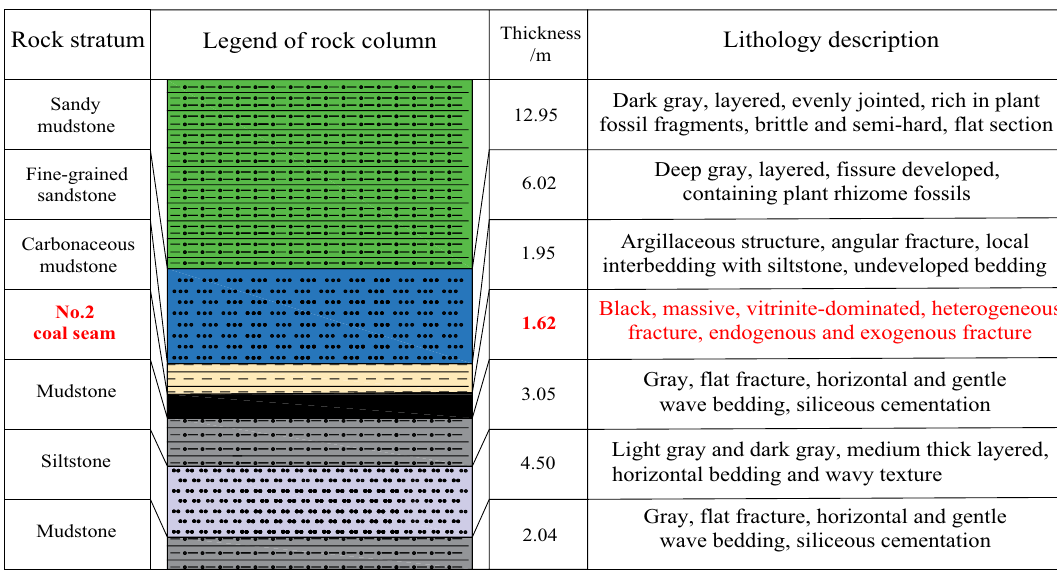
Fig. 2 Coal and rock strata